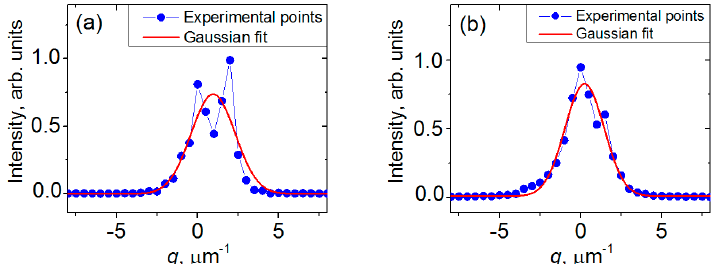
Figure 6. ( a ) The cross-section of a two-dimensional Bragg peak along azimuthal direction and ( b ) the projection of the same Bragg peak on the same direction . It is seen that the cross-section dataset ( a ) deviates from the Gaussian fit (red line), whereas the projection points are fitted with the Gaussian function with higher accuracy.